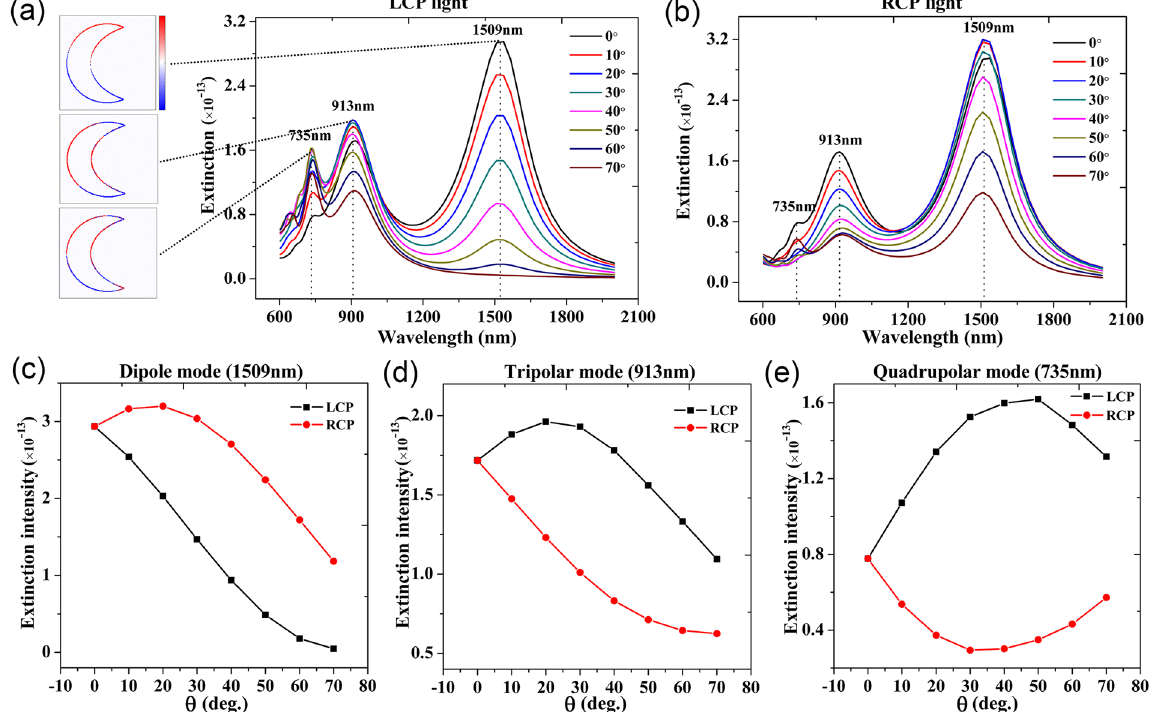
Figure 2. Simulation results of the metal nanocrescent. ( a ) The extinction spectra of the metal nanocrescent for LCP light with the increase of θ . The insets show that charge distribution of the metal nanocrescent for different resonance modes when θ = ° 0 . ( b ) The extinction spectra of the metal nanocrescent for RCP light with the increase of θ . ( c – e ) The dependence of extinction intensities of the metal nanocrescent as the function of θ for the LCP light (black line) and RCP light (red line).